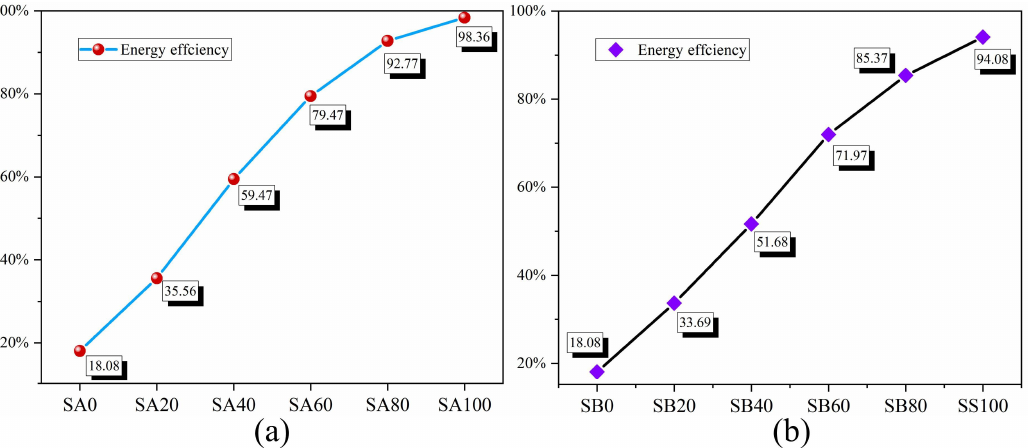
Figure 9. The heat source analysis of asphalt mixtures with different steel slag contents with SA ( a ) and SB ( b ).